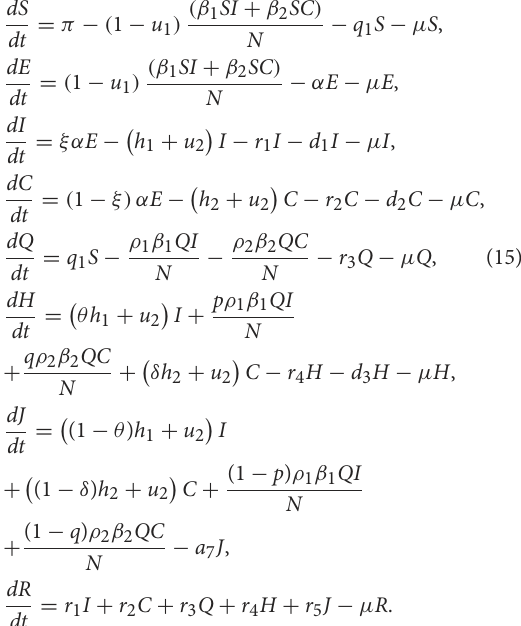
is to minimize the cost